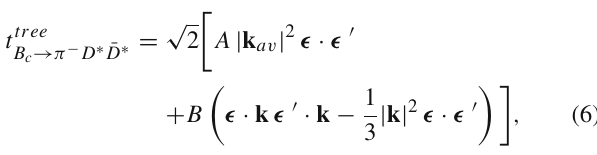
Fig. 4 Mechanism to produce the D ∗ ¯ D ∗ in the final state through tree level ( a ) and rescattering ( b ). R is either the X ( 3922 )( 2 ++ ) or X ( 3943 )( 0 ++